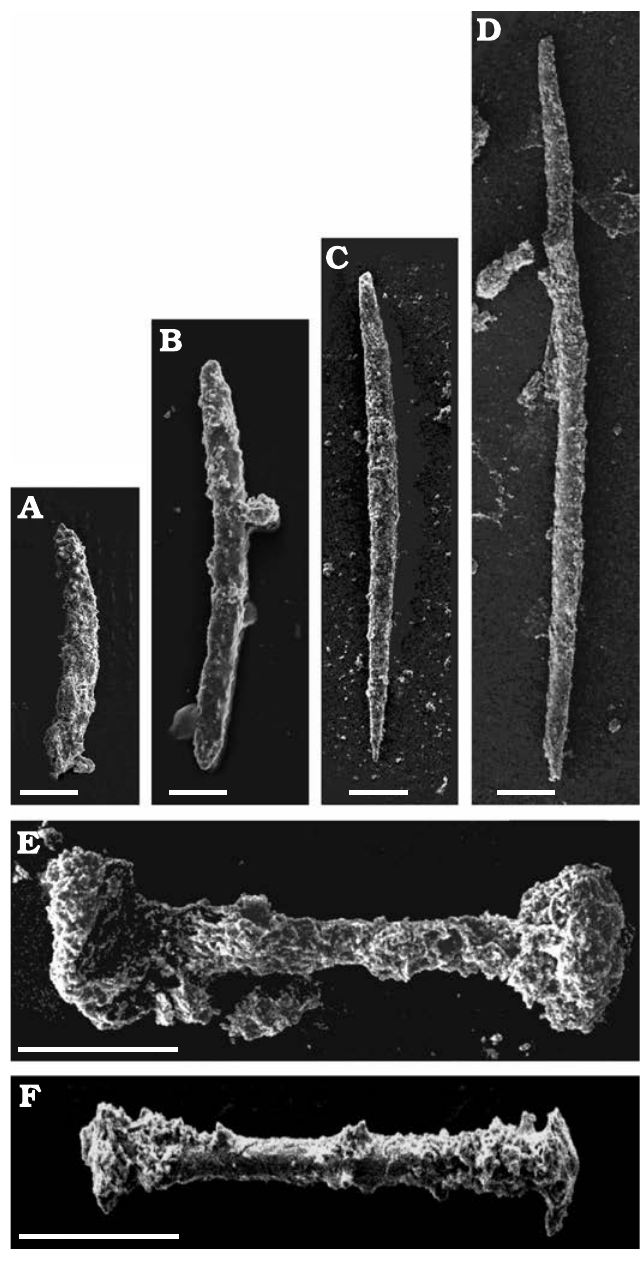
Fig. 5 . Spicular complement of skeleton and gemmules of palaeospongillid sponge Longibirotula antiqua gen. et sp. nov. from Upper Cretaceous–lower Paleocene of Naskal GSI Quarry (India) (slides PGNU/NSKQ/ST-1, 2). A , B . Acan thoxeas short with dense spines. C , D . Oxeas fusiform, long and with acute tips. E , F . Birotules with long shaft. Diagenetic processes affect all spicules to various degree. Scale bars 20